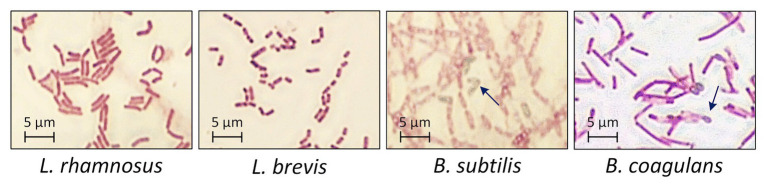
Morphology of probiotic bacteria after 48 h during the fermentation of crude FOS. T = 40°C, pH = 6.8, and agitation = 0.5 vvm. Arrows indicate the typical morphology of bacillus endospores.